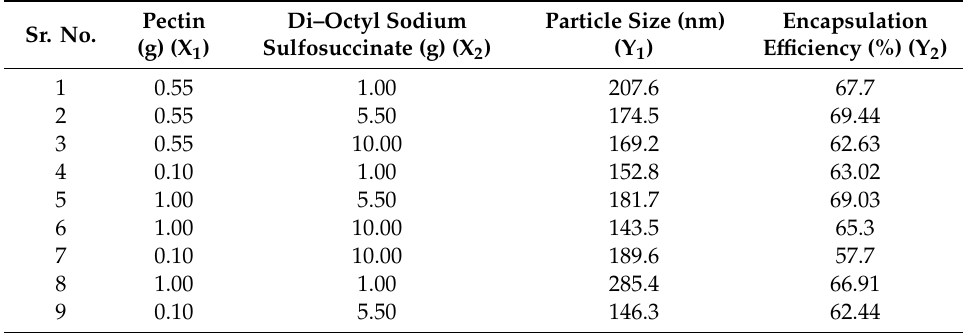
Table 1. Different experimental runs for optimization. Table 1. Di ff erent experimental runs for